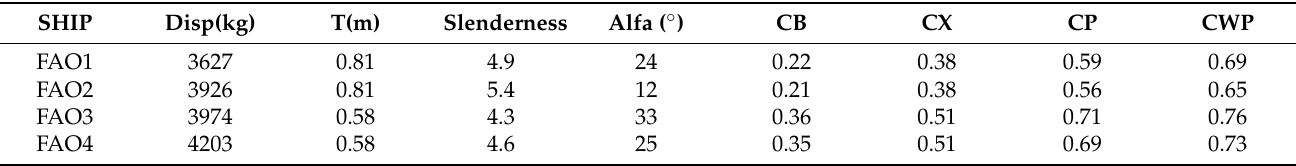
Table 2. Parameters for the models, light